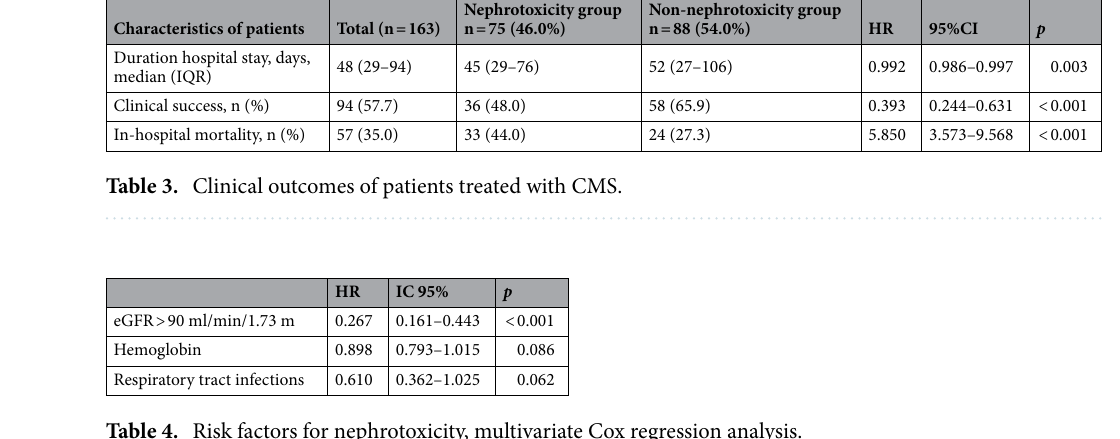
Table 4. Risk factors for nephrotoxicity, multivariate Cox regression analysis.